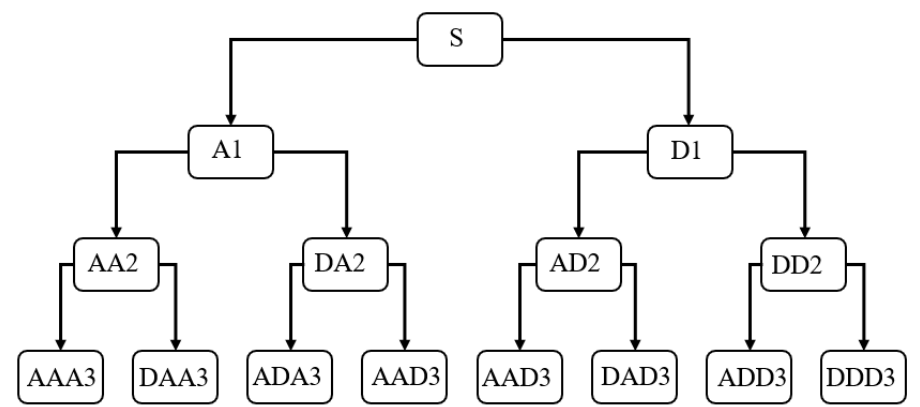
Figure 4. The schematic of wavelet packet decomposition.